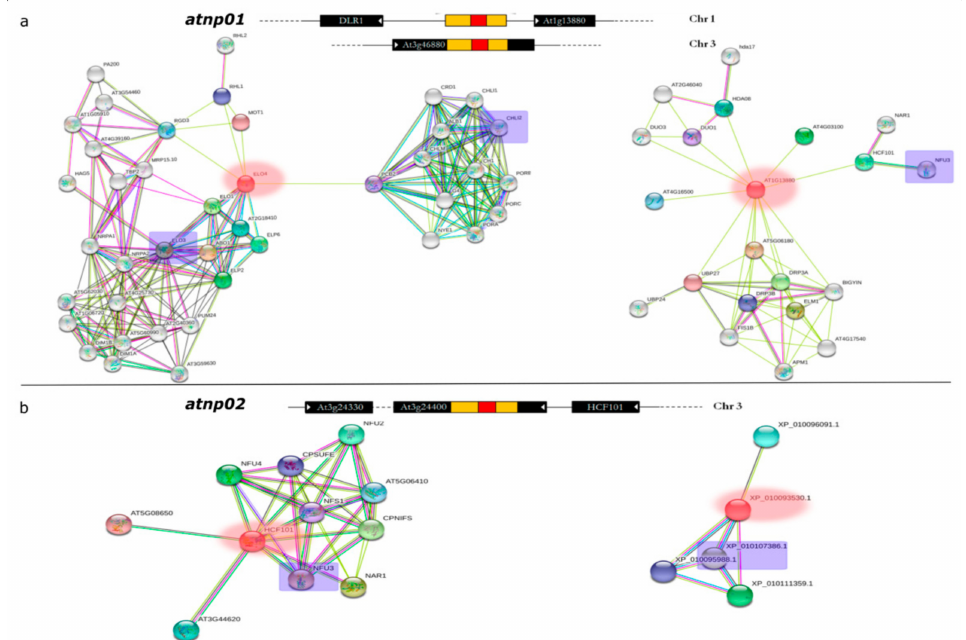
Figure 6. Molecular interaction network of differentially abundant proteins. The mutated genes in the two mutant lines are shown in red in all the networks. A schematic above each network shows the structure of the mutated genes as in [14]. The segment in red and yellow is the insertion element (Ac), the segments in black are the mutated genes and Chr indicates the chromosomes on which these genes are positioned. The putative proteins that were found in the protein analysis and that connect in the network are indicated with blue rectangles. Networks for mutant atnp 01 ( a ) and mutant atnp 02 ( b ). Colored lines and dots indicate different types of interaction evidence (cyan, from curated databases; green, gene neighborhood; blue, gene co-occurrence; pink, experimentally determined; black, co-expression; light blue, protein